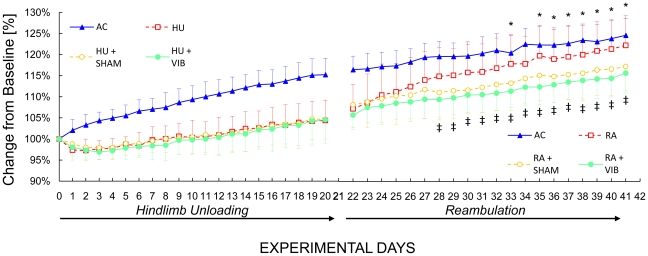
Longitudinal changes in body mass relative to baseline values.After 21 days of unloading, half of the mice from each unloaded group were released and allowed to re-ambulate. Age-matched controls: AC, solid triangles; hindlimb unloaded: HU, empty squares; sham loaded during unloading: HU+SHAM, empty circles; vibrated mice during unloading: HU+VIB, solid circles; reambulation: RA, empty squares; sham loaded during reambulation: RA+SHAM, empty circles; vibrated mice during reambulation: RA+VIB, solid circles. ‡: p<0.05 between RA+VIB and RA mice. *: p>0.05 between AC and RA mice (ANOVA and SNK).